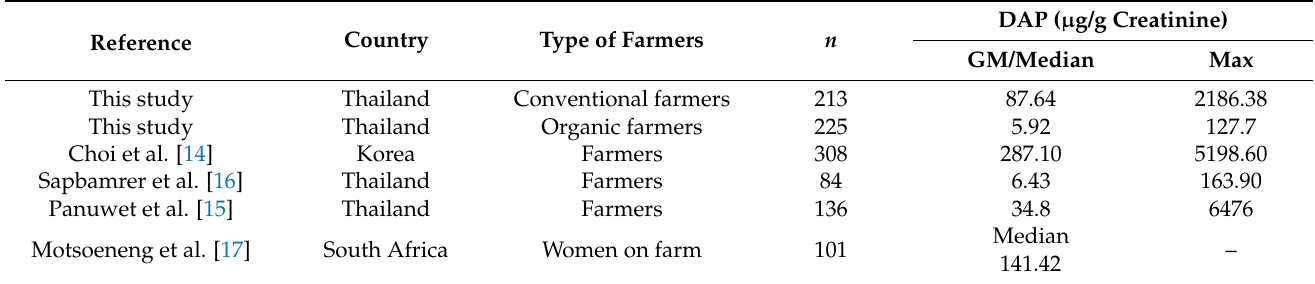
Table 4. Comparison of DAP ( µ g/g creatinine) for different groups of farmers.